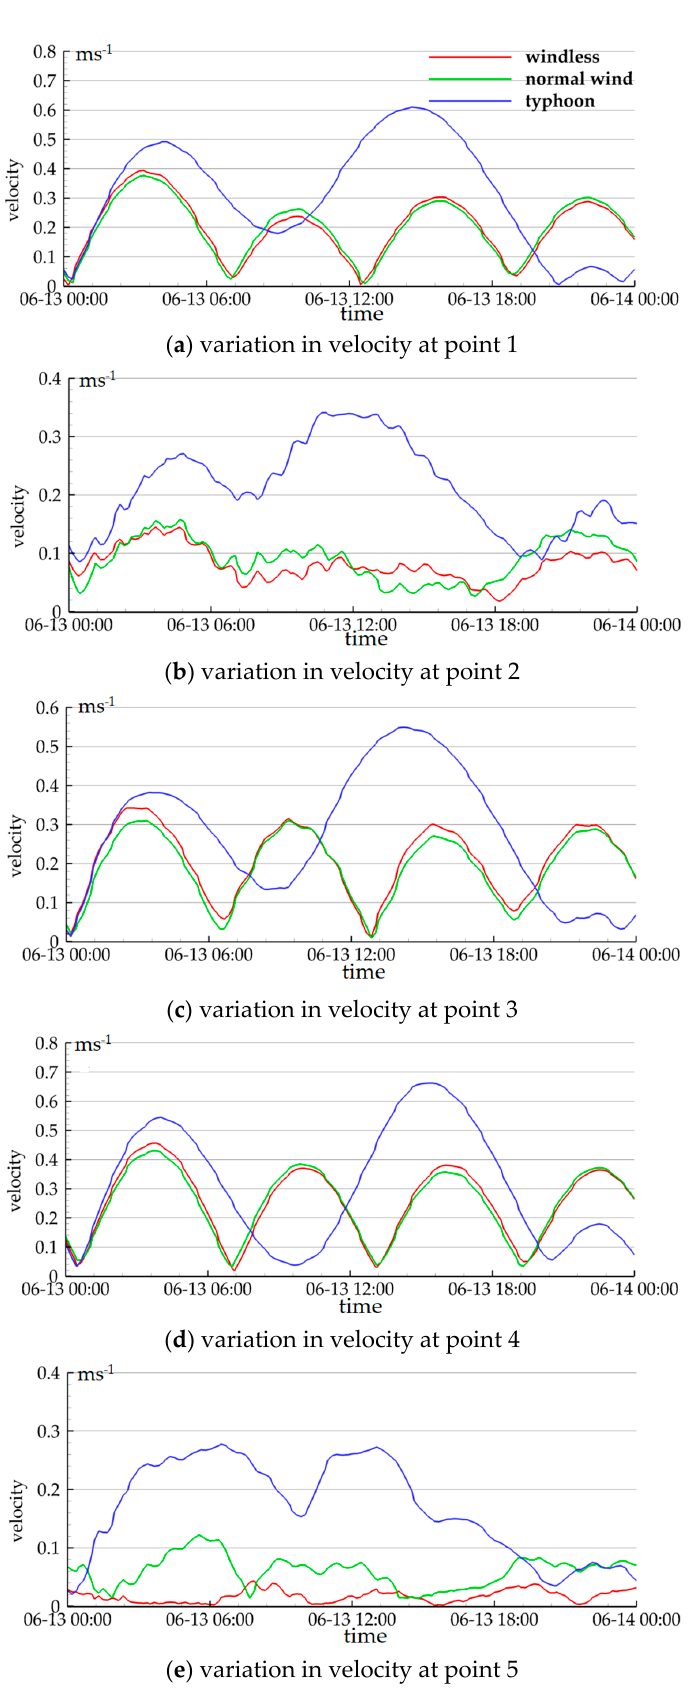
Figure 13. Variation in velocity under different wind